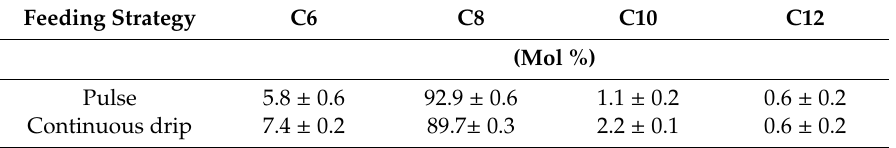
Table 3. Monomer composition of polymer synthesized from octanoic acid using P. putida LS46 under different fed-batch strategies. Tolerances indicate standard deviations between three biological